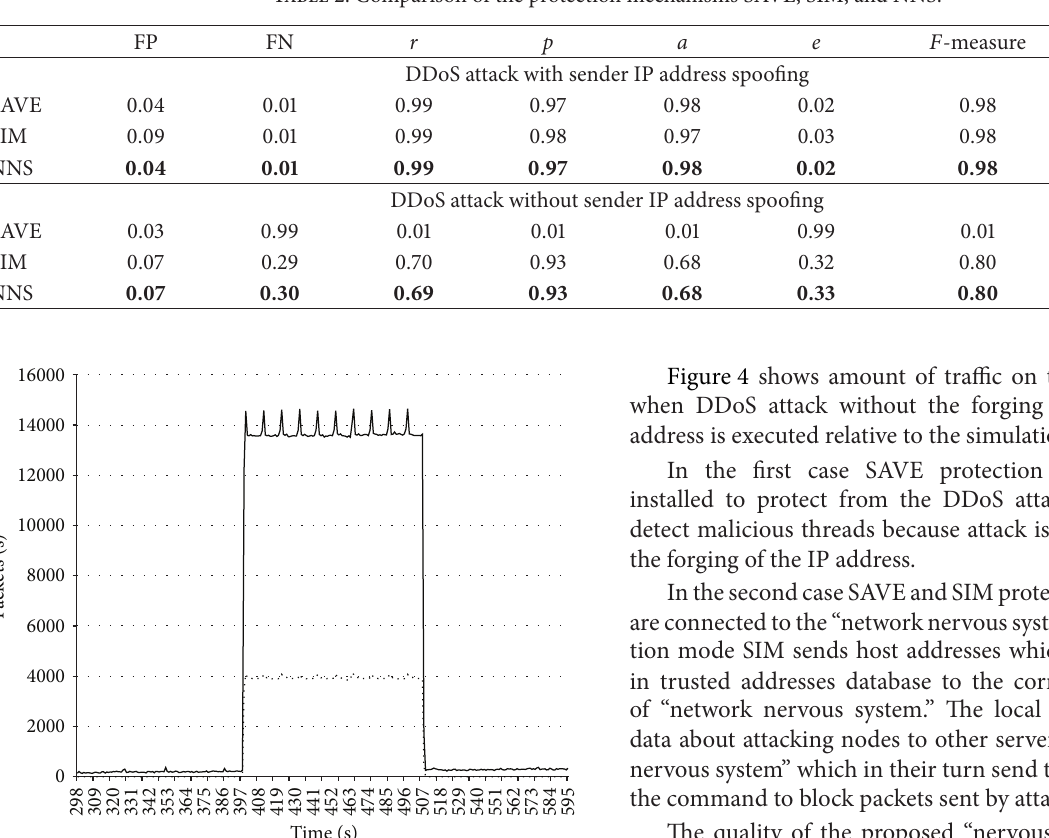
Table 2: Comparison of the protection mechanisms SAVE, SIM, and NNS.